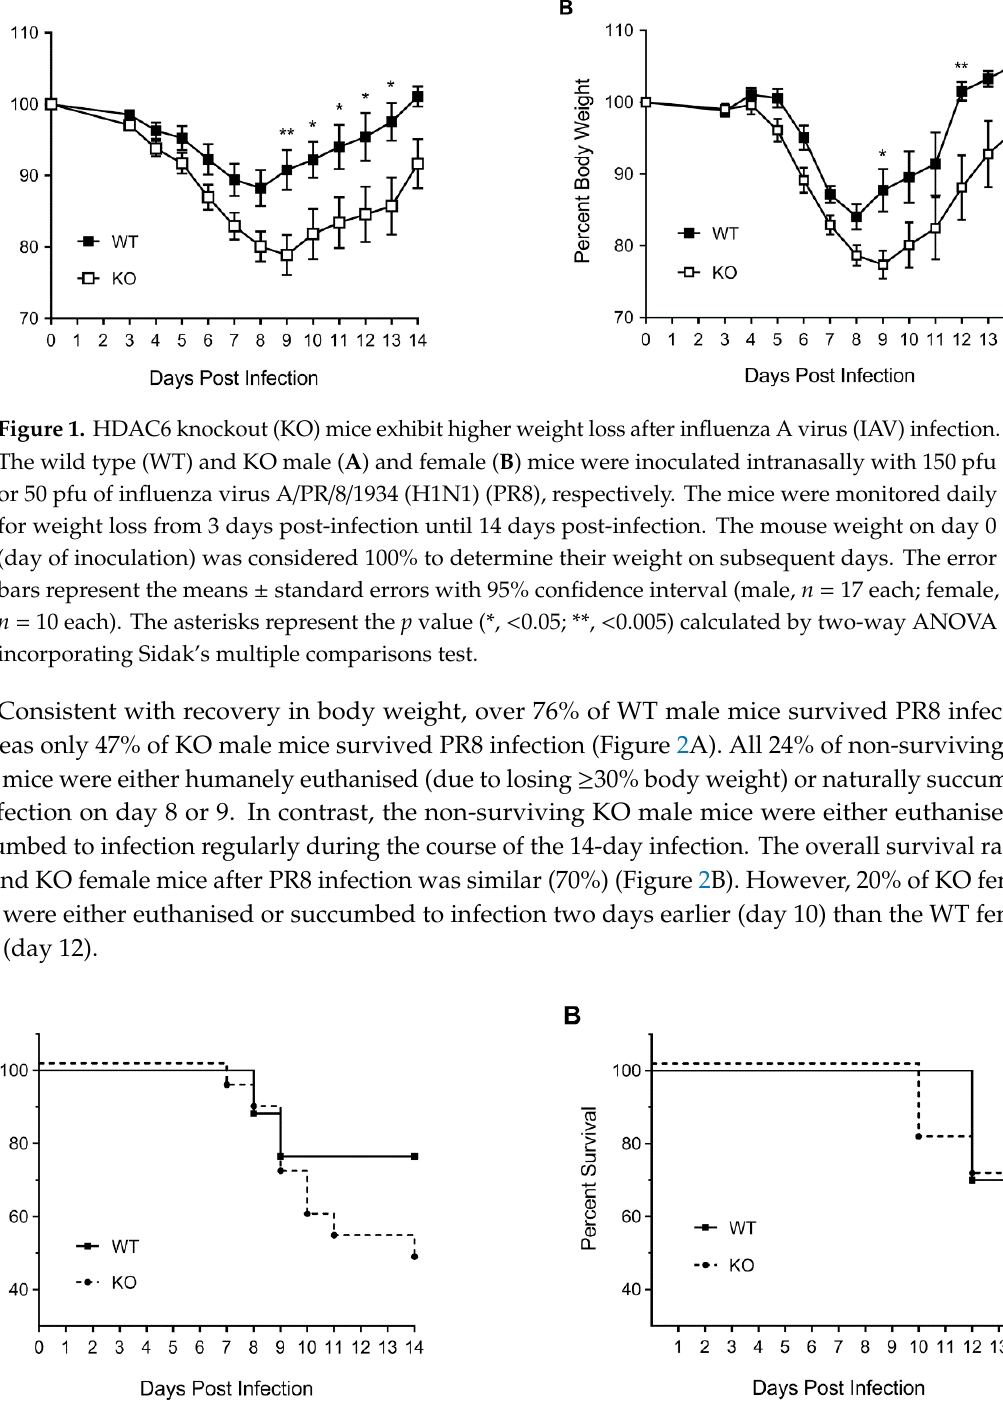
Figure 2. HDAC6 KO mice have lower survival rate than WT mice after IAV infection. The WT and KO male ( A ) or female ( B ) mice inoculated intranasally with 150 pfu or 50 pfu of PR8, respectively, in Figure 1 were monitored for survival due to infection over 14 days. The solid circles and squares represent the days of death (male, n = 17 each; female, n = 10 each).